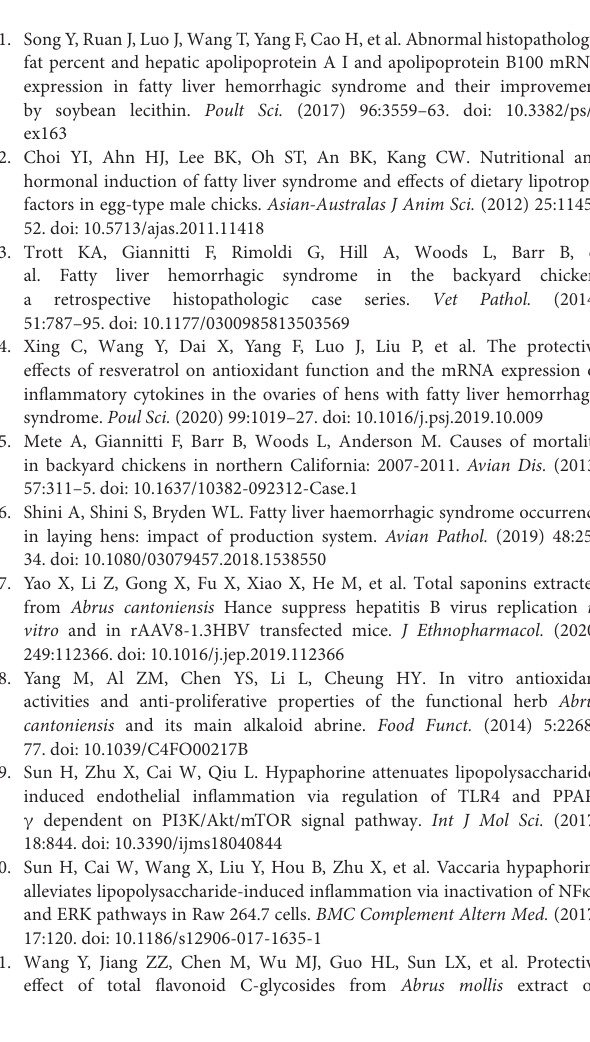
(UPLC)-Q-TOF/MS analysis.